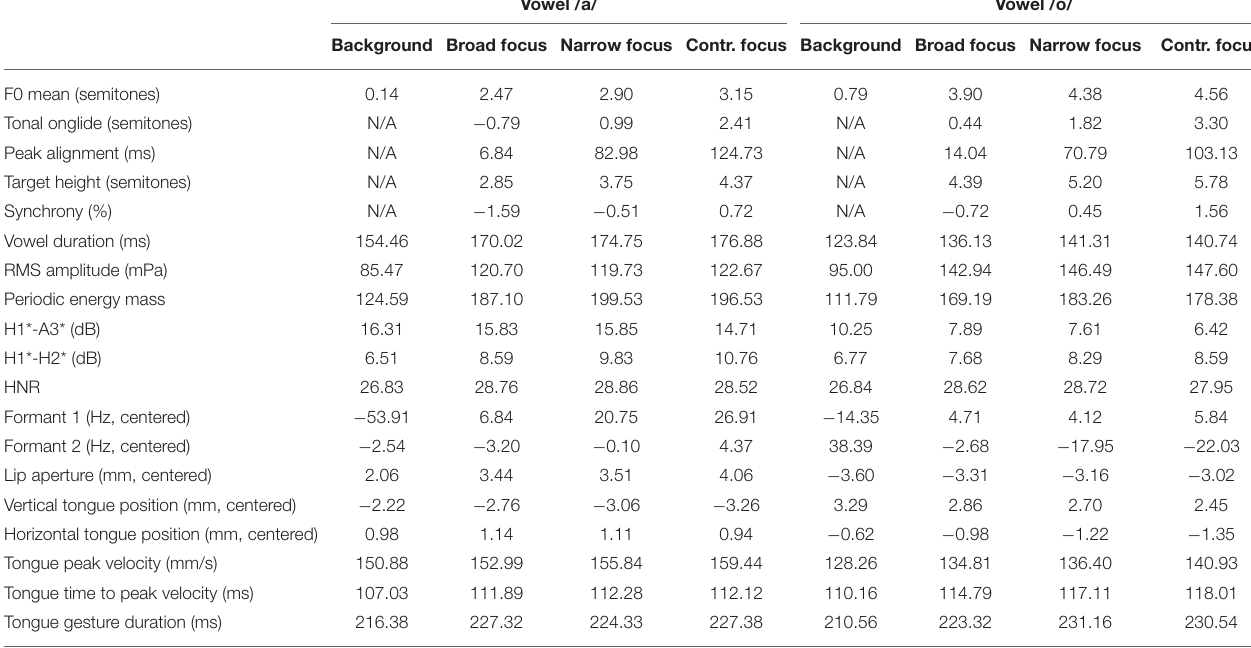
TABLE 1 | Descriptive means of all variables.